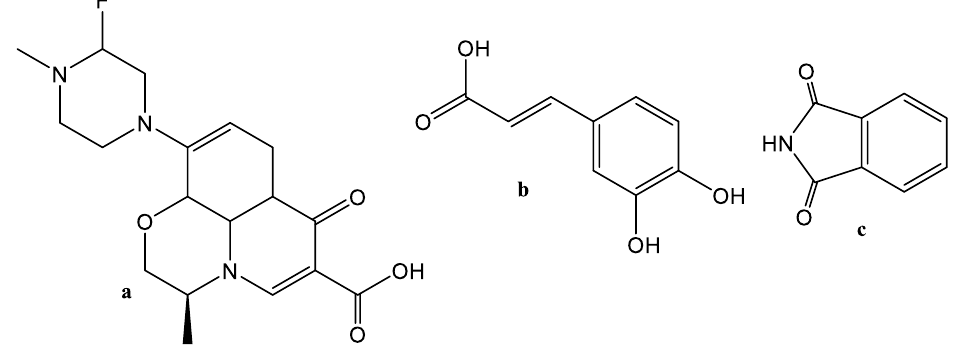
Figure 1. Chemical structures of LEV ( a ), CFA ( b ), and PTH ( c ).